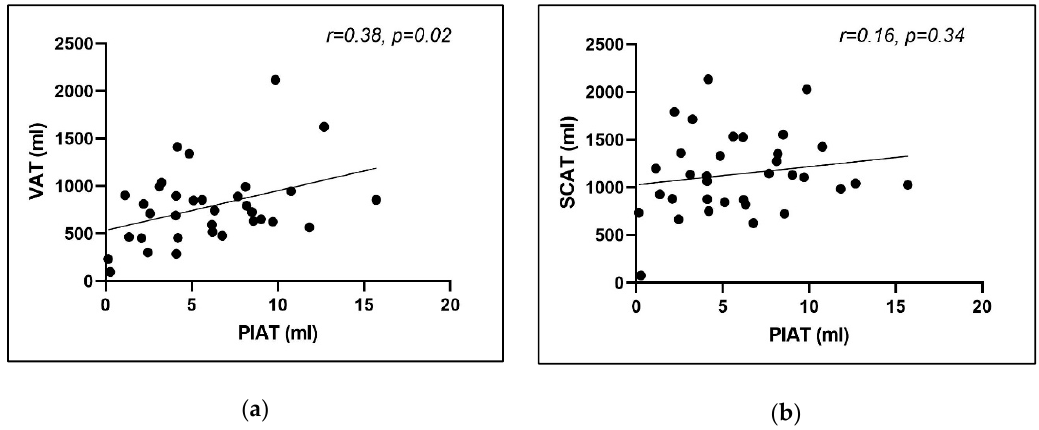
Figure 7. Correlation between mean PIAT volume and ( a ) mean visceral adipose tissue; ( b ) mean subcutaneous adipose tissue.